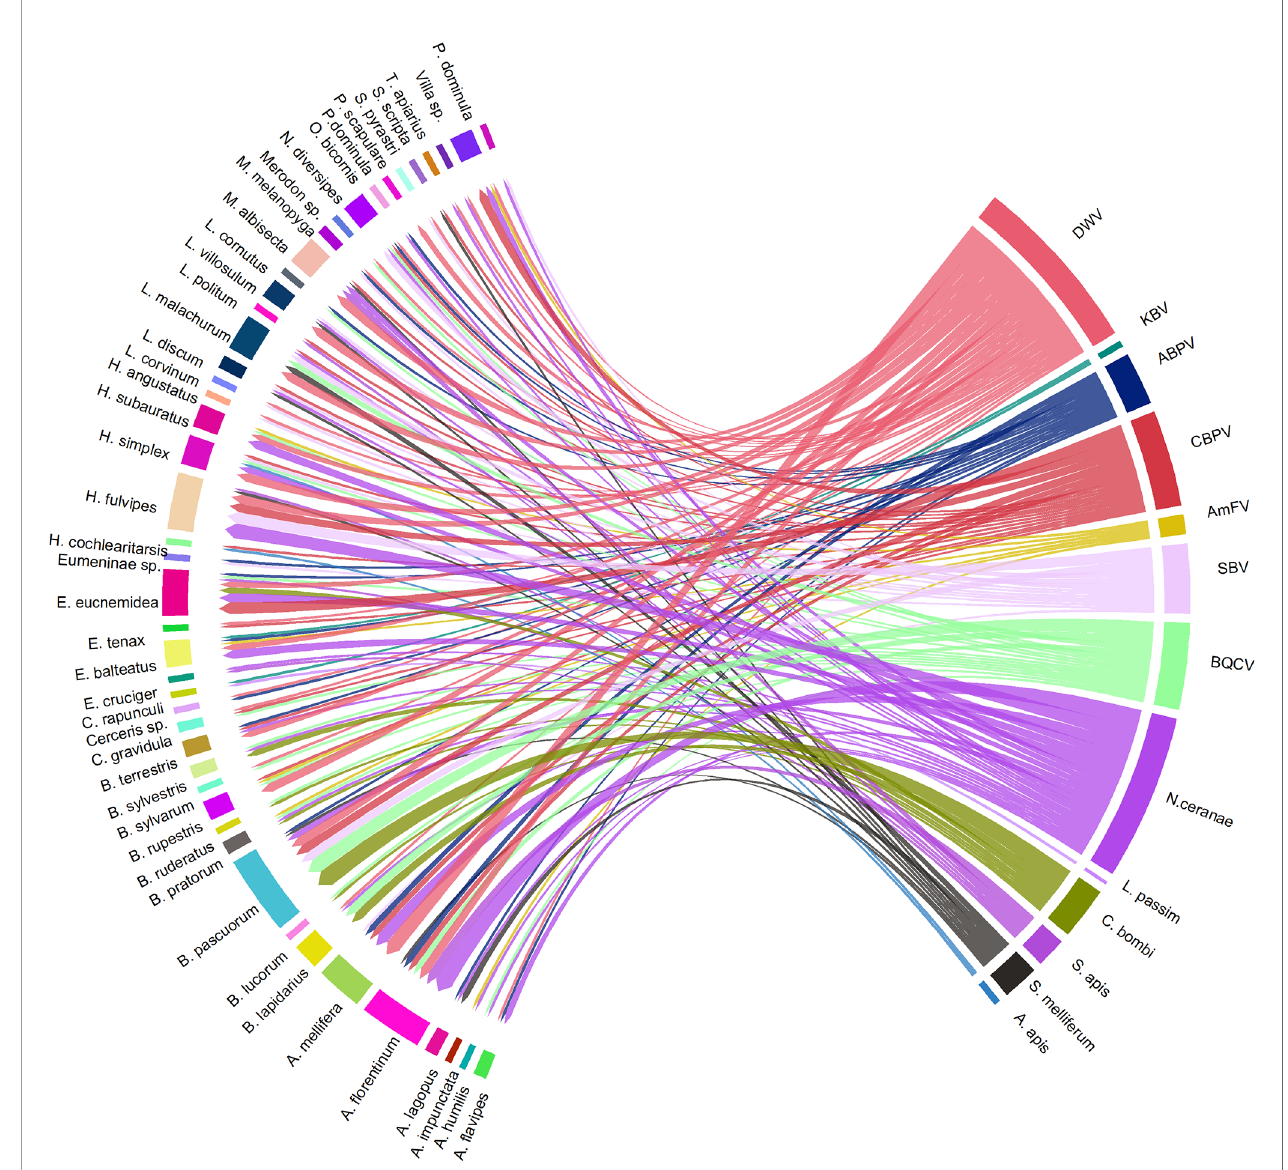
FIGURE 11 | A visual schematisation of the subsample of pathogens that were involved in multiple infections related to their hosts. The arrow thickness denotes the number of co-infections observed within the same host